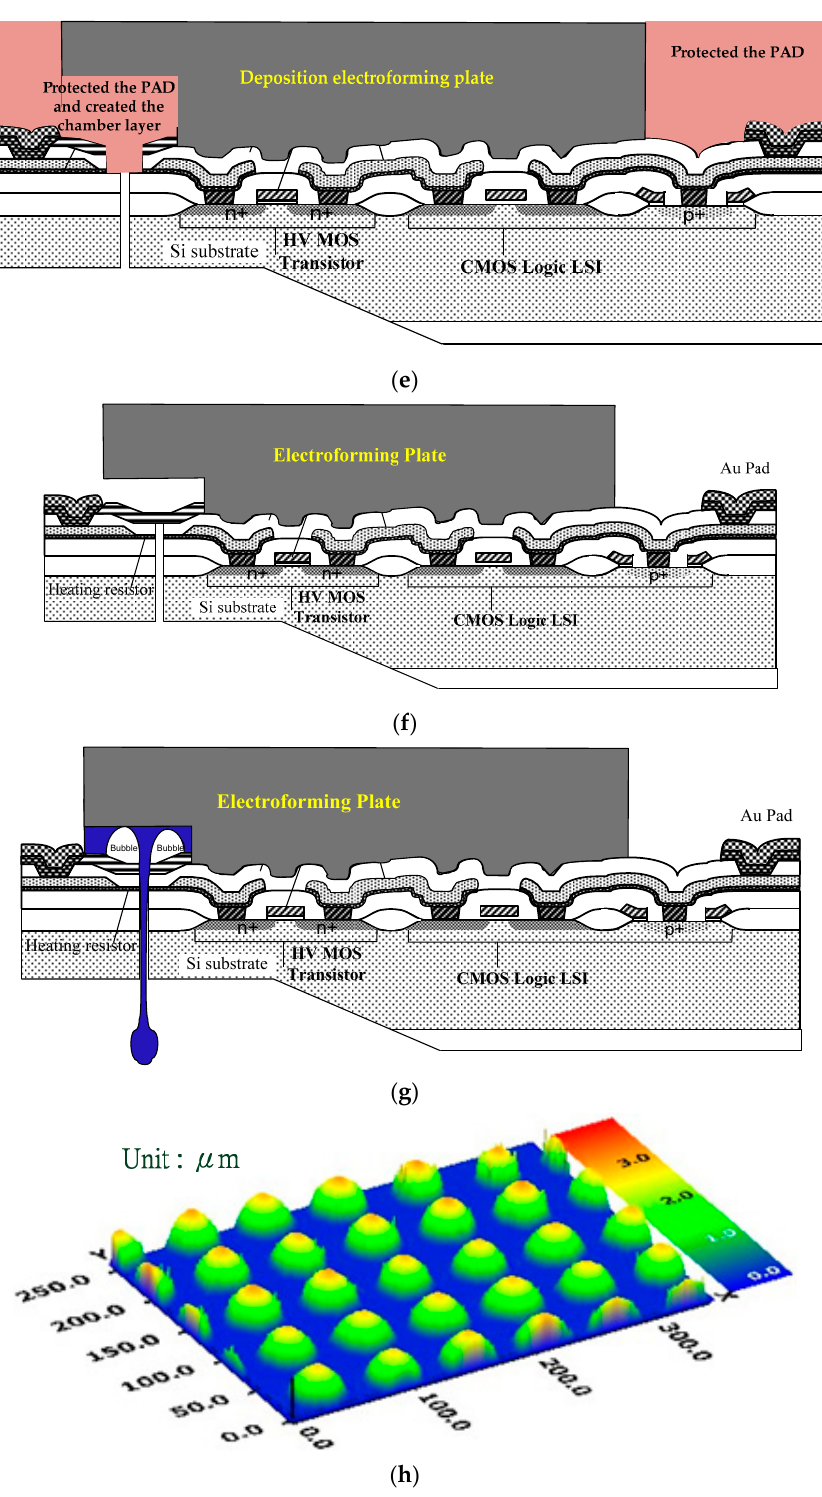
Figure 6. ( a ) Complementary metal-oxide-semiconductor (CMOS) circuits substract; ( b ) Partially thin substrate orifice area as a nozzle plate; ( c ) CMOS circuit by covering the photoresistance on the 3D sacrificial layer for perforation; ( d ) The protected the PAD and created the chamber layer; ( e ) Deposition electroforming plate; ( f ) Removed the protected the PAD and created the chamber layer and finished a liquid MEMS ink-jet head; ( g ) Thermal bubble generation droplet; and, ( h ) droplet arrangement profile.